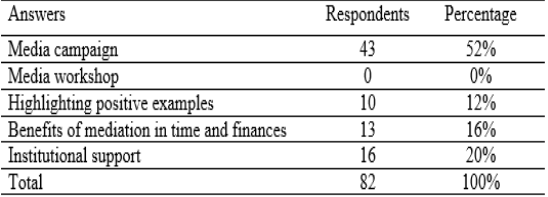
Table 7. Table of received answers to question number 17